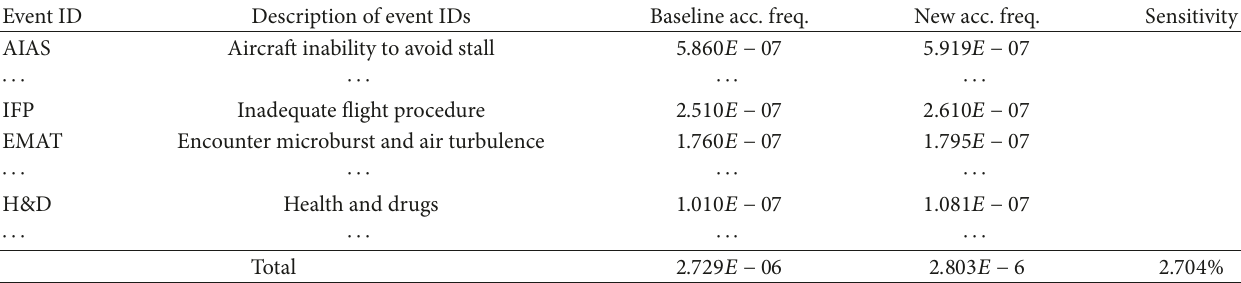
Table 4: Example of calculation for combined influence event sensitivity.